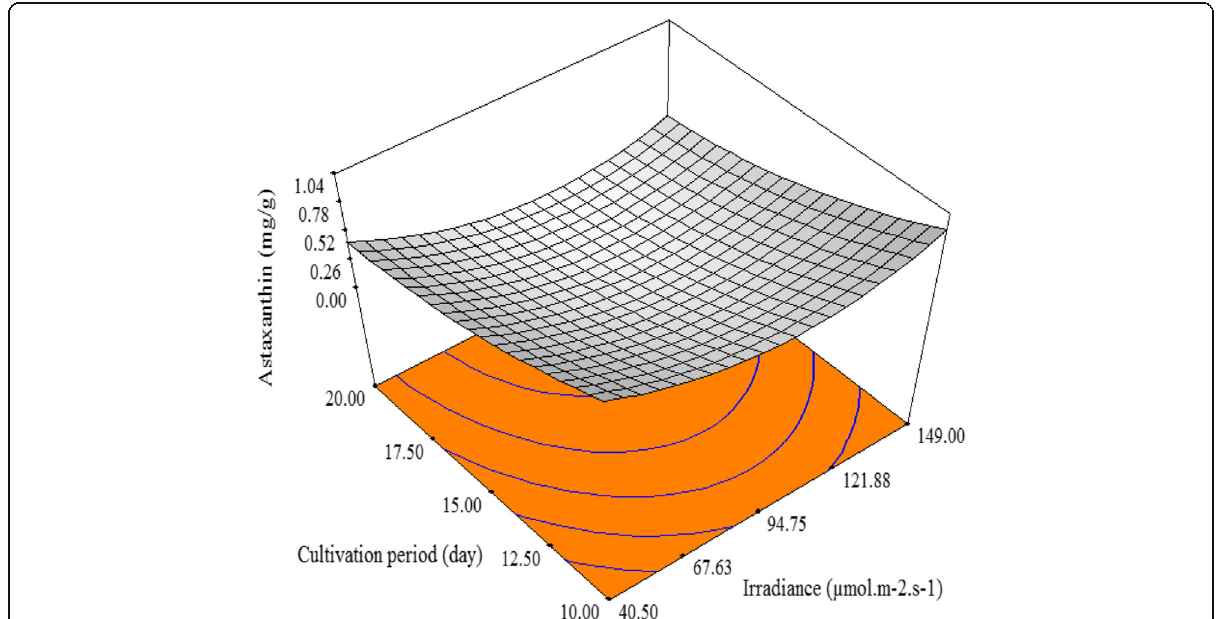
Fig. 2 The RSM model graph of astaxanthin